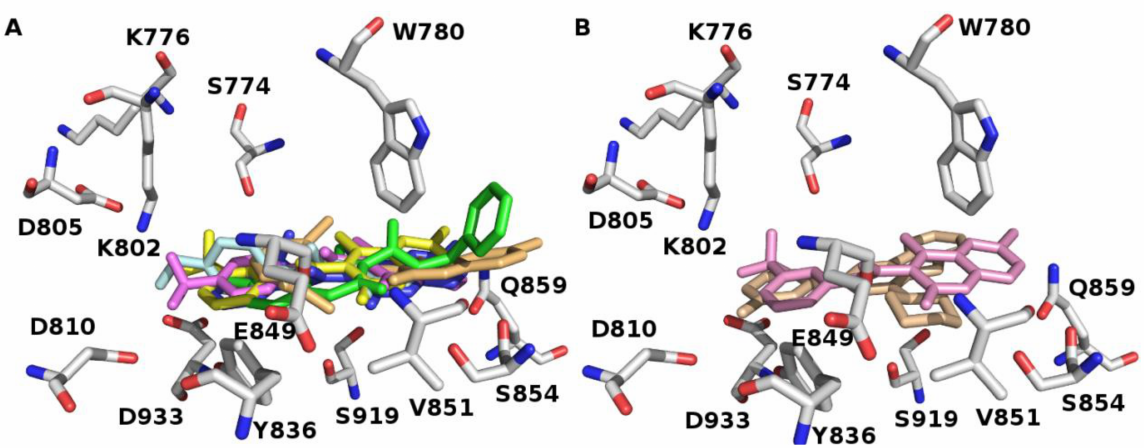
Figure 4. Kinase domain of ( A ) 2RD0 accommodating the IF docked geometries of some of the verified molecules and ( B ) superposing of the IF docked pose of 10 (pink color) and native pose of (X6K) (gold color). Some of the key binding residues are presented and H atoms are invisible for clarification. Picture made by PYMOL